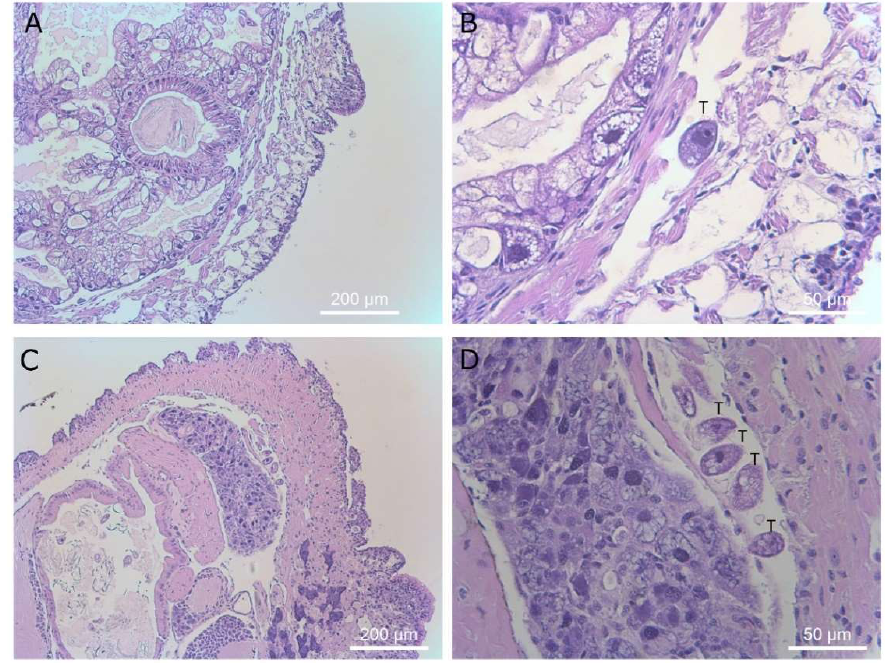
Figure 10. Histological sections of slugs showing ciliates in the muscle tissue between the skin and body cavity of the slug. Magnifications are×40 (panel A and C ) and ×400 (panel B and D ). Ciliates are marked with a “T” above the cells in panels ( B , D ).